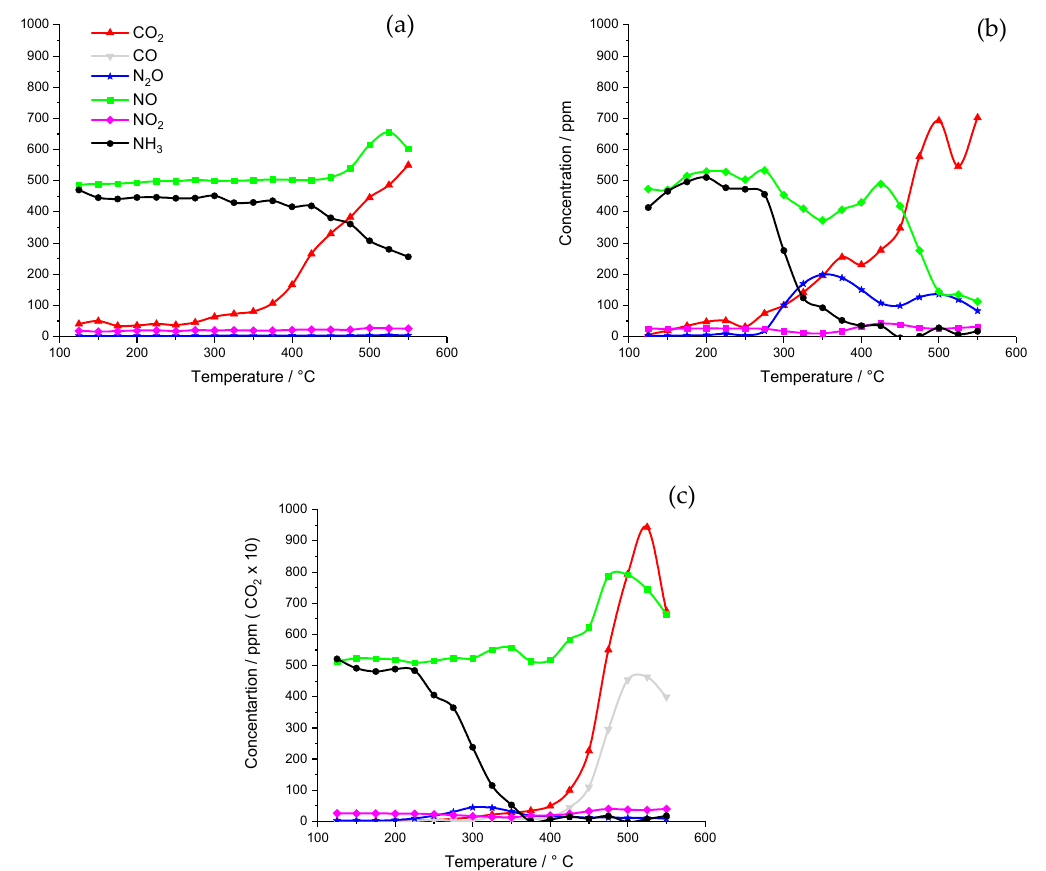
Figure 1. Variation of reactants and products as a function of temperature for NOx reduction and soot combustion where the simulated exhaust gas consisted of 500 ppm NO, 500 ppm NH 3 , 8% O 2 , with a balance of N 2 . The temperature was increased in 25 °C intervals from 125 to 550 °C. A total of 0.25 g of catalyst was mixed in a 10:1 ratio by mass with soot. The catalysts were prepared by the following methods: (a) Chemical Vapor Impregnation (CVI) at 60 °C, (b) CVI at 70 °C, and (c) CVI at 90 °C.